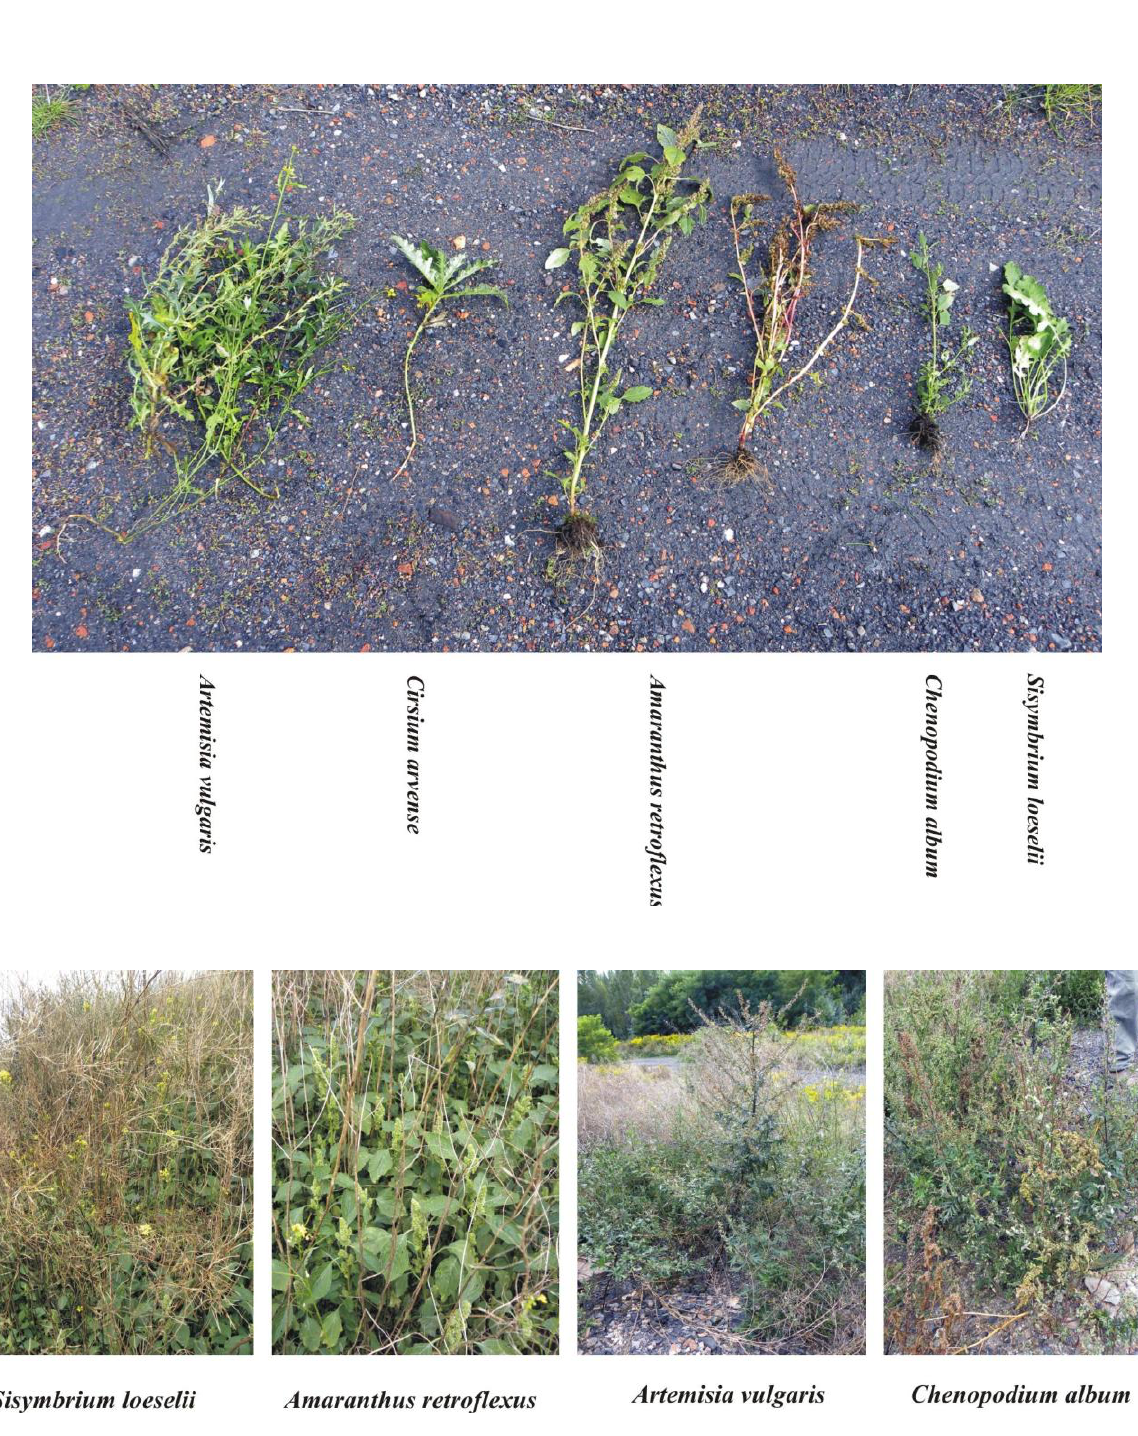
Fig. 3. Plant succession at the western part of the hot spot located on the southern slope of the Katowice-Wełnowiec dump on 3a) May 27, 2010, 3b) October 1, 2010 and 3c) August 31, 2011 (J.